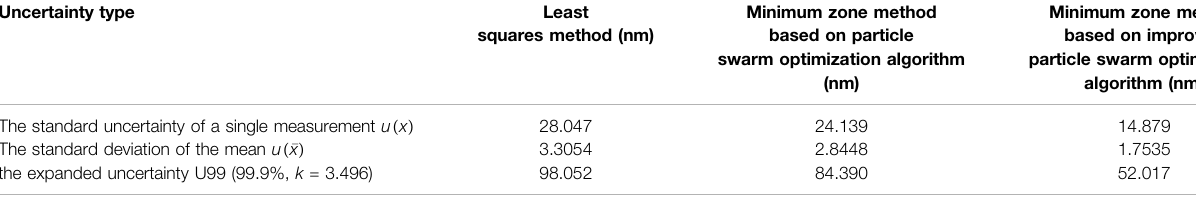
TABLE 3 | Two algorithms for evaluating the uncertainty of fl atness error of the SHS sample of 5 × 5 μ m. Uncertainty type